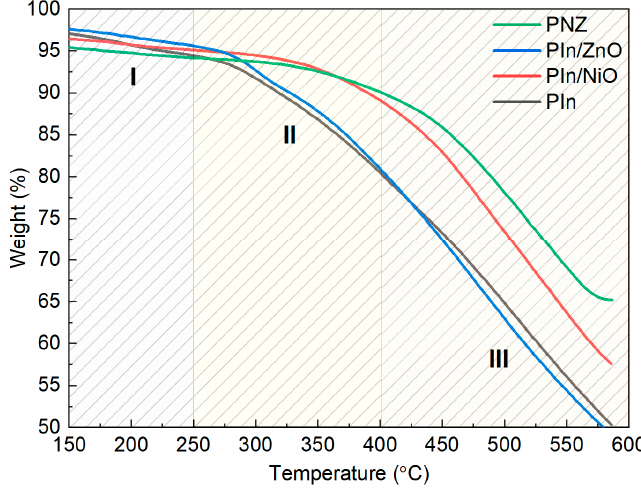
Figure 4. TGA spectra of the synthesized PIn and its metal composites.